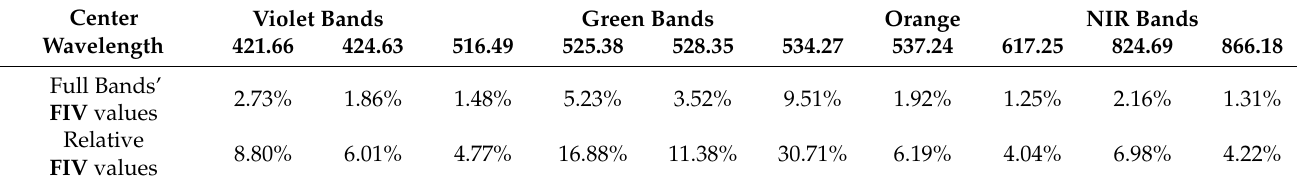
Table 4. Selected bands of center wavelength and relative values.